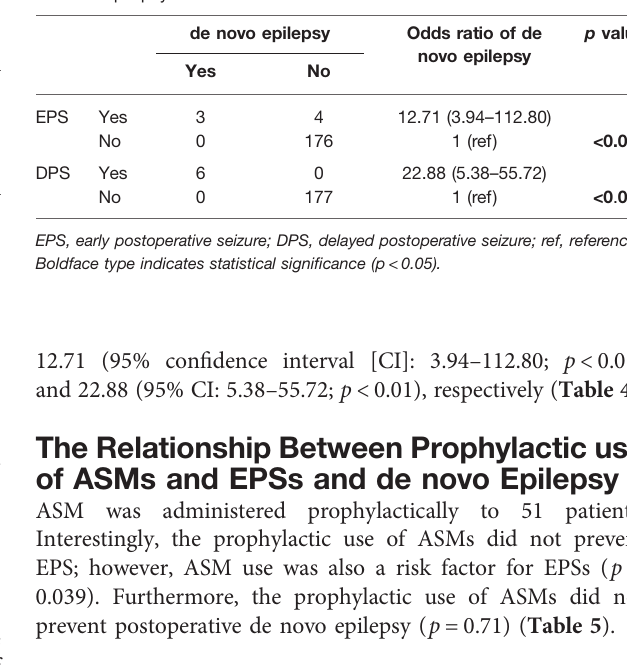
TABLE 3 | The relationship of EPS, DPS and previously diagnosed epilepsy. TABLE 4 | The relationship and univariate regression analysis of EPS, DPS and de novo